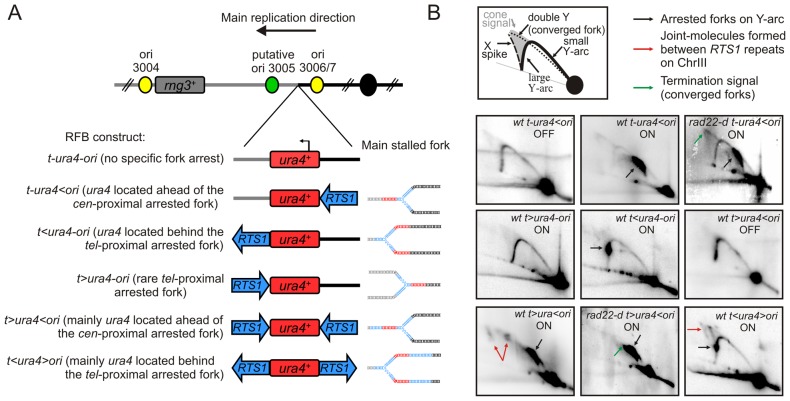
Conditional replication fork-arrest assays.A. Diagrams of fork-arrest constructs. Centromere-proximal and telomere-proximal regions are represented in black and grey, respectively. Strong or putative replication origins (ori) and the centromere are indicated by yellow, green and black circles, respectively. Blues arrows indicate the polarity of the RTS1-RFB. The ura4+ gene is indicated in red and the arrow indicates its direction of transcription. Representations of the primary arrested fork structure are given for each construct. The name of each fork-arrest construct is given using the following nomenclature: “t” and “ori” refer to the telomere and the replication origin 3006/7, respectively; “<“ and ”>” indicate the RTS1-barrier and its polarity (< blocks replication forks moving from the ori3006/7 towards the telomere, and > blocks replication forks moving from the telomere towards the origin 3006/7. B. Diagrams of replication intermediates (RIs) within the AseI fragment analysed by 2DGE (top panel). Representative RIs analysed by 2DGE in indicated strains in OFF (Rtf1 being repressed) and ON (Rtf1 being expressed) conditions. Signal corresponding to arrested forks, joints-molecules (JMs) and termination structures are indicated by black, red and green arrows, respectively. Note that the t>ura4-ori construct does not result in a strong fork arrest as the RTS1-RFB is not orientated in the main direction of replication (see text for details).